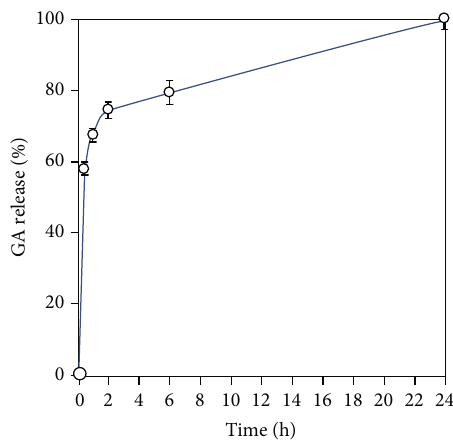
Figure 9: In vitro release of the GA encapsulated within m-CMC- g-PMAA microcapsules in PBS of pH 5.5